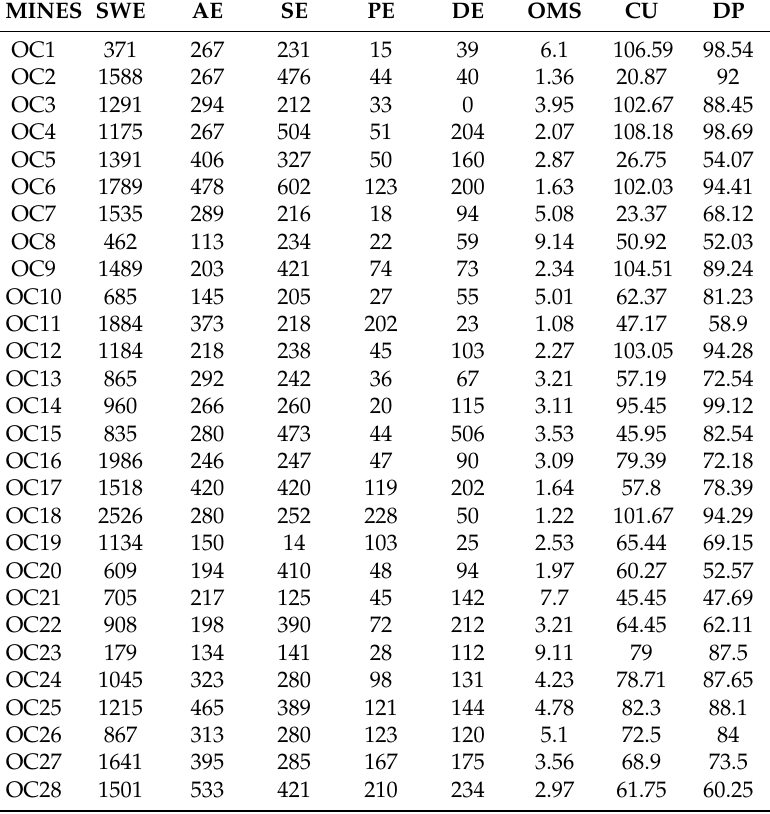
Table A1. Opencast Mines Data for